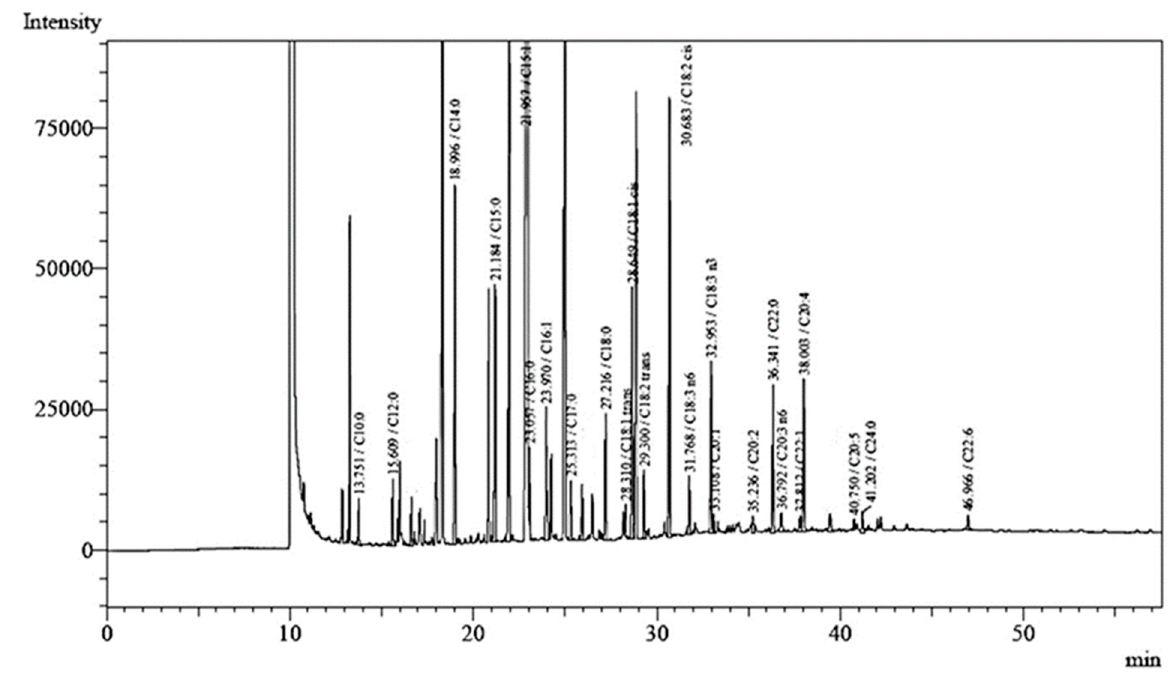
Figure 6. Gas chromatogram of injected FAMEs from UI with major fatty acids peaks.